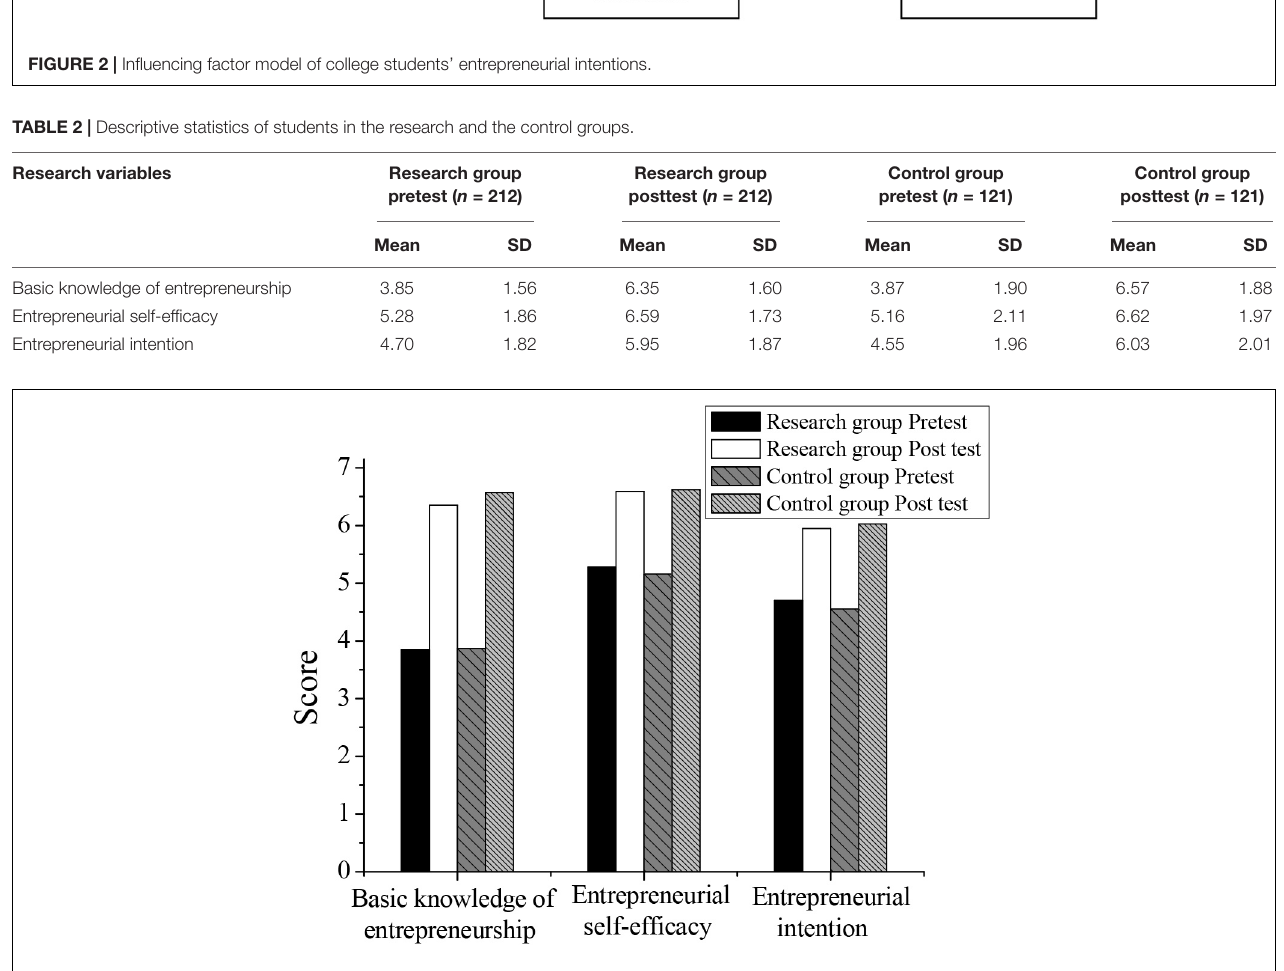
FIGURE 3 | Comparison of the descriptive statistical results of two groups of